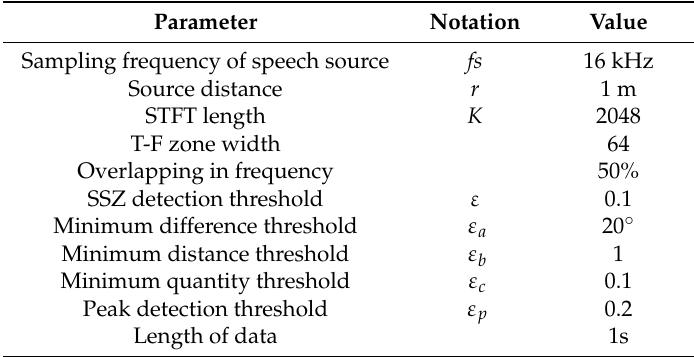
Table 2. Experimental parameters.